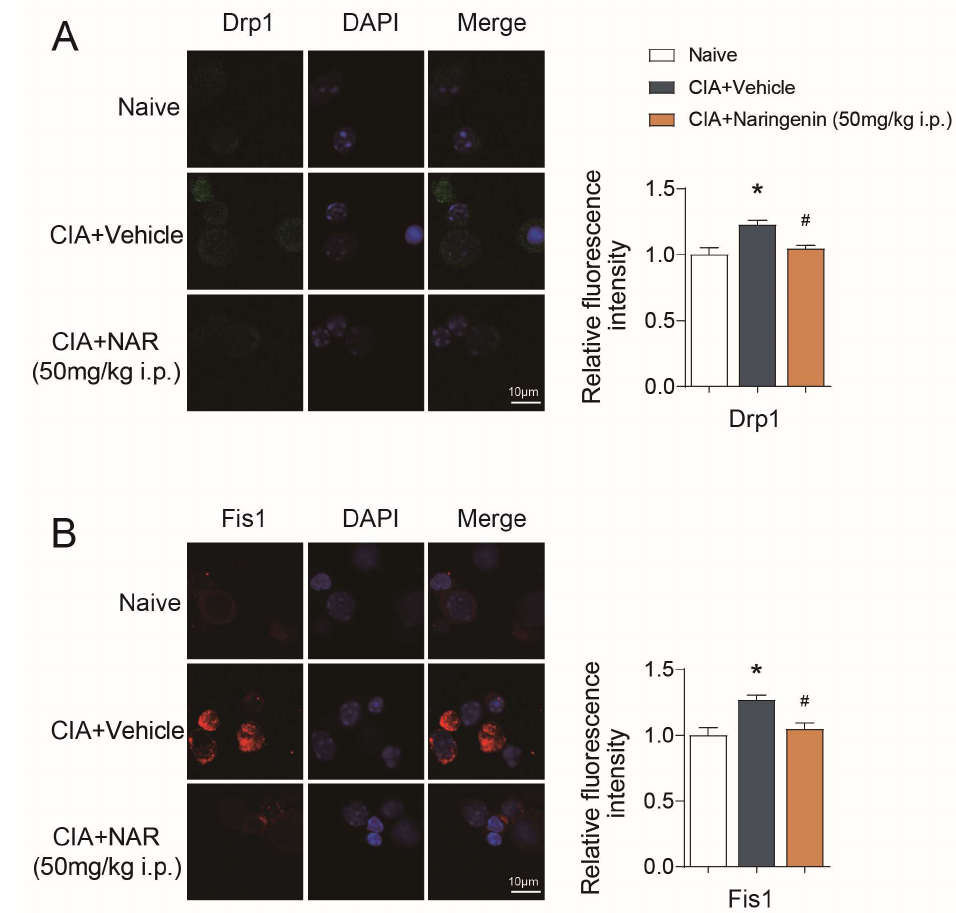
Figure 5. NAR improves mitochondrial fission. ( A ) Immunofluorescence showing the expression of Drp1 in the CD4 + T lymphocyte in different groups. ( B ) Immunofluorescence showing the expression of Fis1 in the CD4 + T lymphocyte in different groups. * p < 0.05 vs. naive group, # p < 0.05 vs. CIA model group, by repeated-measures one-way ANOVA followed by post hoc Dunnett’s multiple comparisons test. All scale bars are 10 µ m. The data are presented as means ± SEM (3 sections and 3–5 different fields of each section were randomly selected for semi-quantitative evaluation).